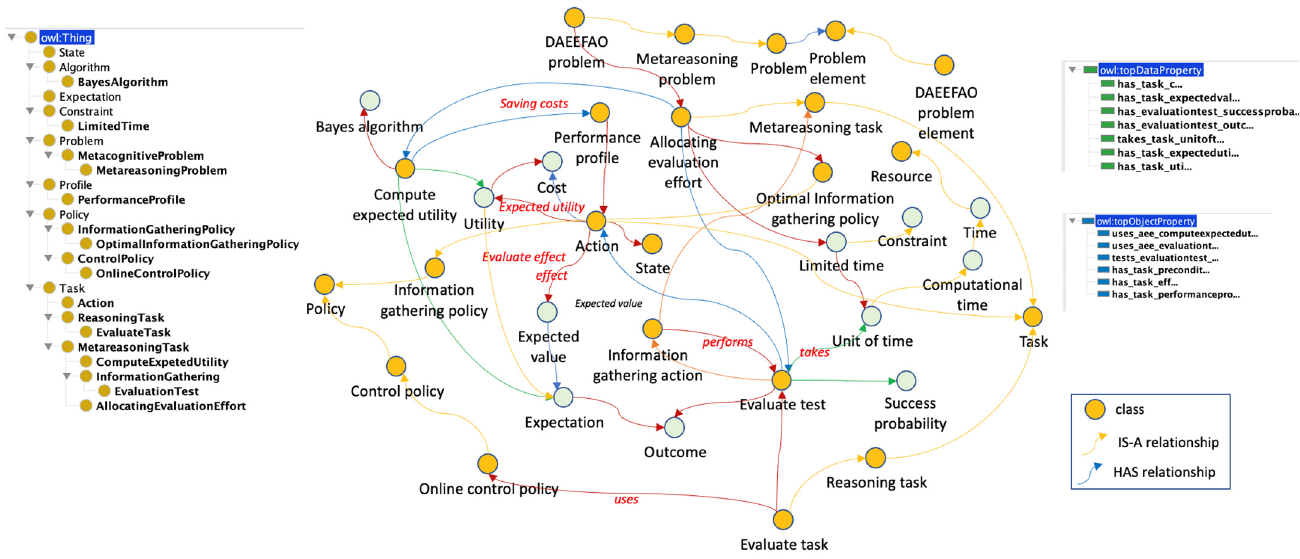
Figure 7. The AEEP subontology.